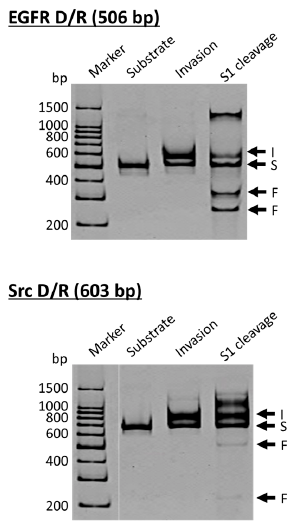
Figure 3. Site-selective scission of DNA/RNA hybrids by ARCUT. The DNA strand in the upper gel is a part of the epidermal growth factor receptor (EGFR; from human chromosome 7), whereas the DNA in the lower gel is from the proto-oncogene tyrosine-protein kinase (Src; from human chromosome 20). S, DNA/RNA hybrid; I, invasion complex; F, the scission fragments. Scission conditions: [substrate DNA/RNA duplex] = 10 nM, [pcPNA] = 50 nM, [S1 nuclease] = 9 units/ μ L, [NaCl] = 280 mM, and [ZnSO 4 ] = 1 mM at pH 4.6 and 25 °C for 3 min.